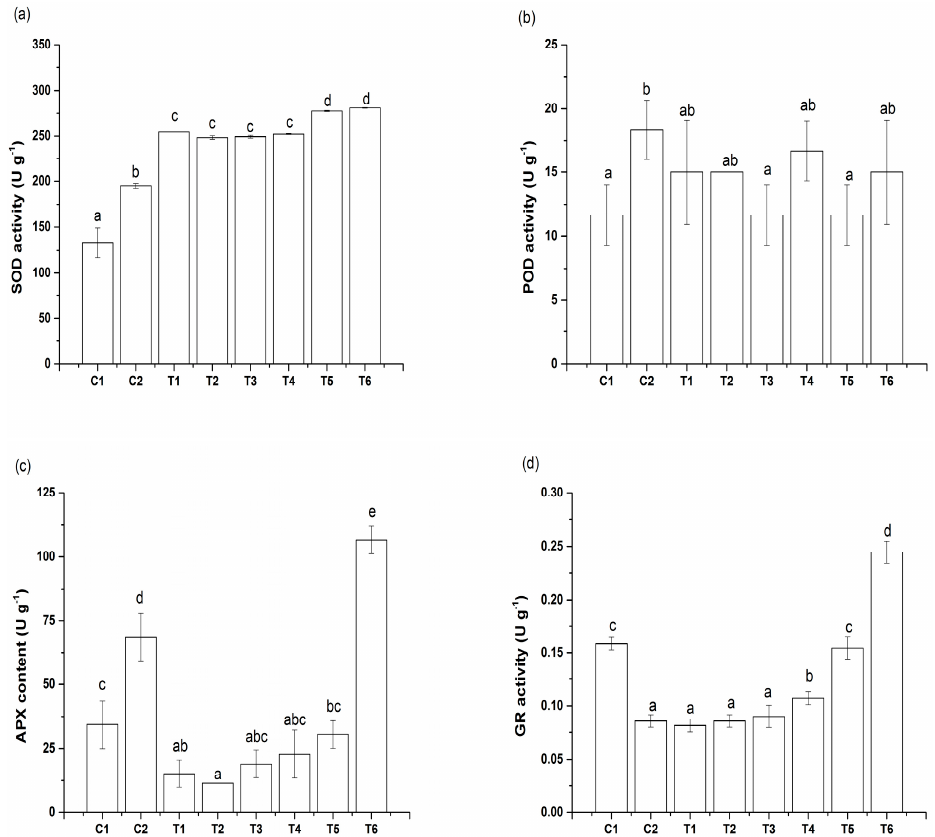
Figure 3. Effects of IAA on superoxide dismutase (SOD; a ), Peroxidase (POD; b ), Ascorbate peroxidase (APX; c ) and glutathione reductase (GR; d ) activities of spinach seedlings under Cu stress. Values and error bars indicate means ±standard deviation ( n = 3). Different letters indicate a significant difference between treatments at p < 0.05 according to Duncan’s multiple-comparisons test.